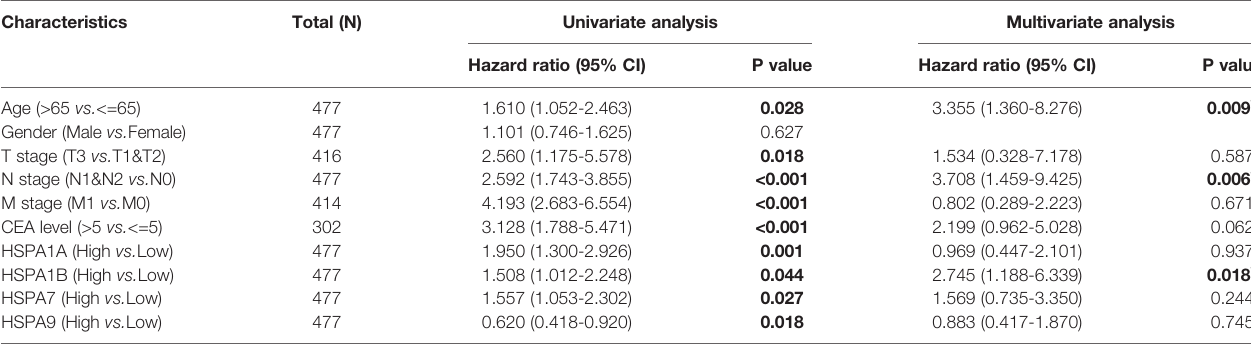
TABLE 2 | Univariate analysis and multivariate cox regression